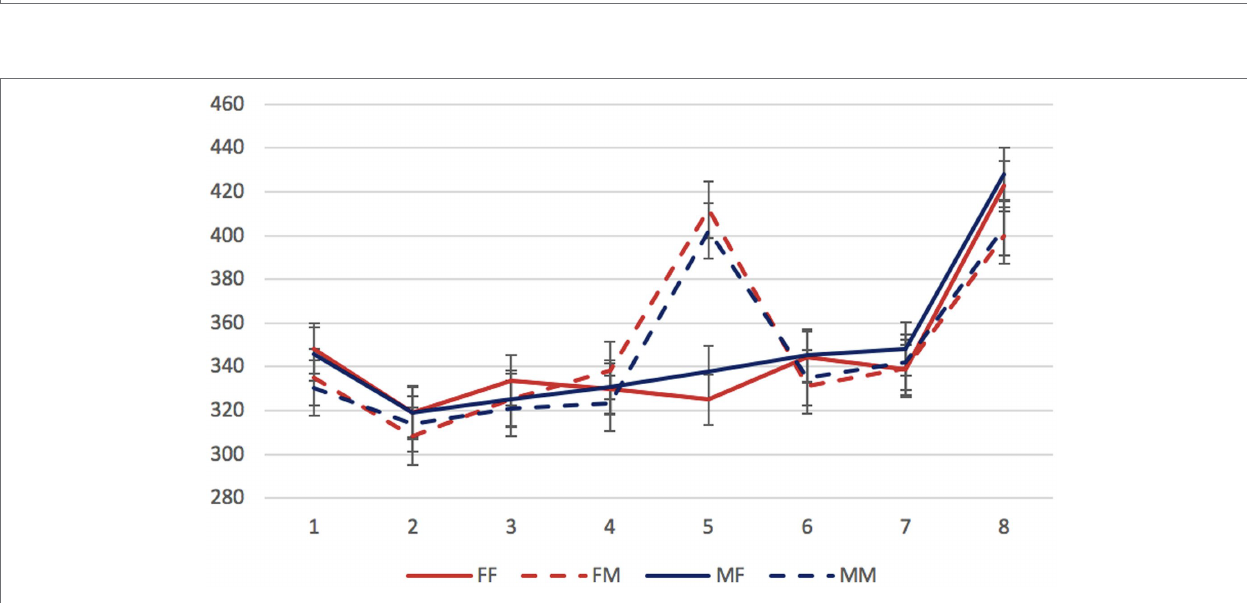
FIGURE 2 | Experiment 1, the non-syncretic inanimate dependent group: mean RTs per region (in ms) in the four experimental conditions. Regions: N 1 (head)—